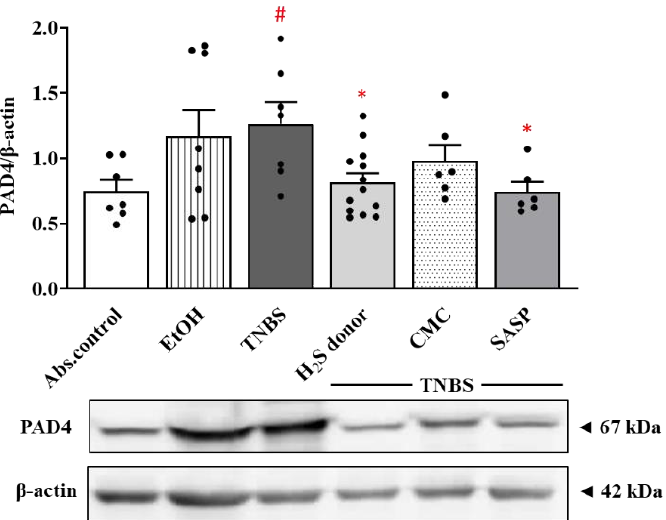
Figure 2. Changes of the expression of PAD4 NETosis marker after H 2 S donor administration. Absolute control (no treatment); EtOH (50% ethanol, the solvent of TNBS); TNBS (2,4,6-trinitrobenzenesulfonic acid enema); H 2 S donor (TNBS + 18.75 µ M/kg/day Lawesson’s reagent); CMC (TNBS + 0.5% carboxymethylcellulose, the vehicle of Lawesson’s reagent); SASP (TNBS + 50 mg/kg/day sulfasalazine, as a positive control). Results are presented as mean + S.E.M.; n = 6–13/group; one-way ANOVA, Holm–Sidak post hoc test, # p < 0.05 absolute control vs. TNBS; * p < 0.05 TNBS vs. TNBS + treatments.